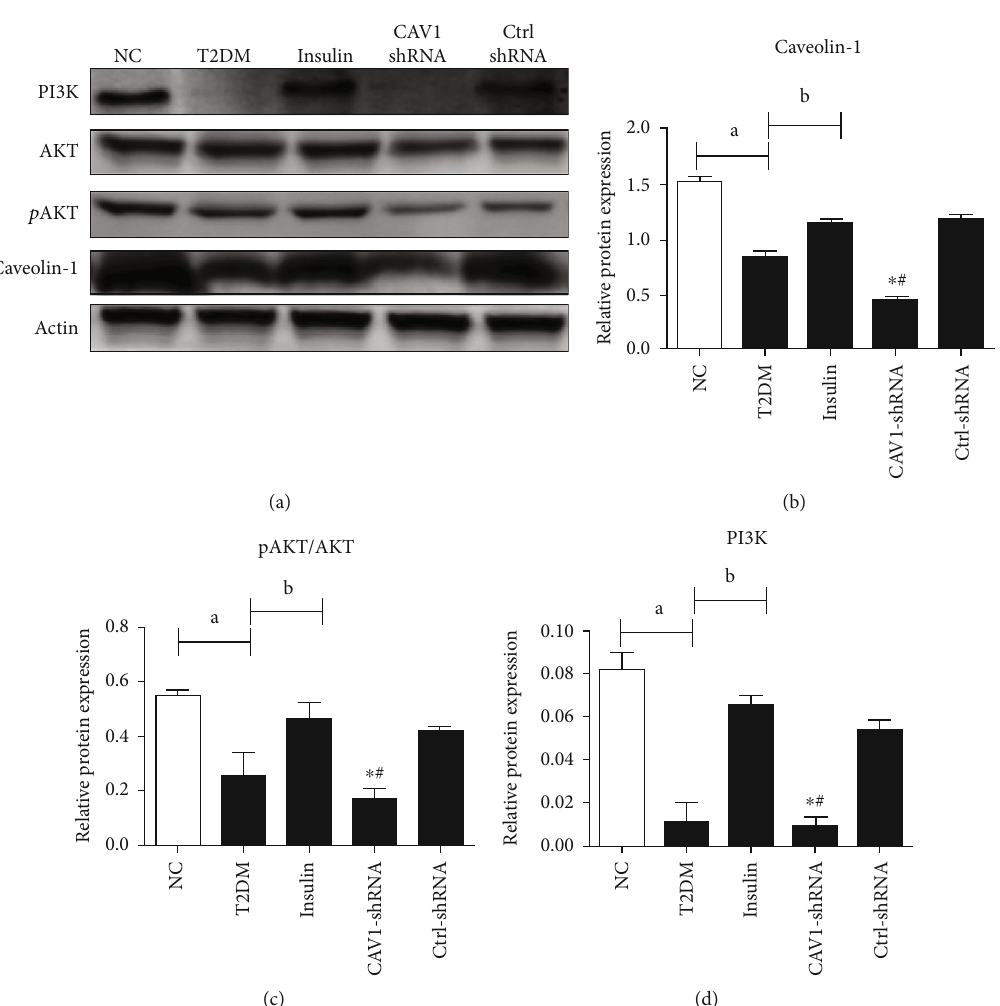
Figure 5: The expression of Caveolin-1, p-AKT/AKT, and PI3K among fi ve di ff erent groups (a). The band intensity of Caveolin-1, p- AKT/AKT, and PI3K was quanti fi ed as shown in (b – d), respectively (data are expressed as mean ± SEM . ∗ P < 0 : 05 compared with the insulin group. # P < 0 : 05 compared with the Ctrl-shRNA group; a represents P < 0 : 05 compared with the NC group, and b represents P < 0 : 05 compared with the T2DM group, n = 5